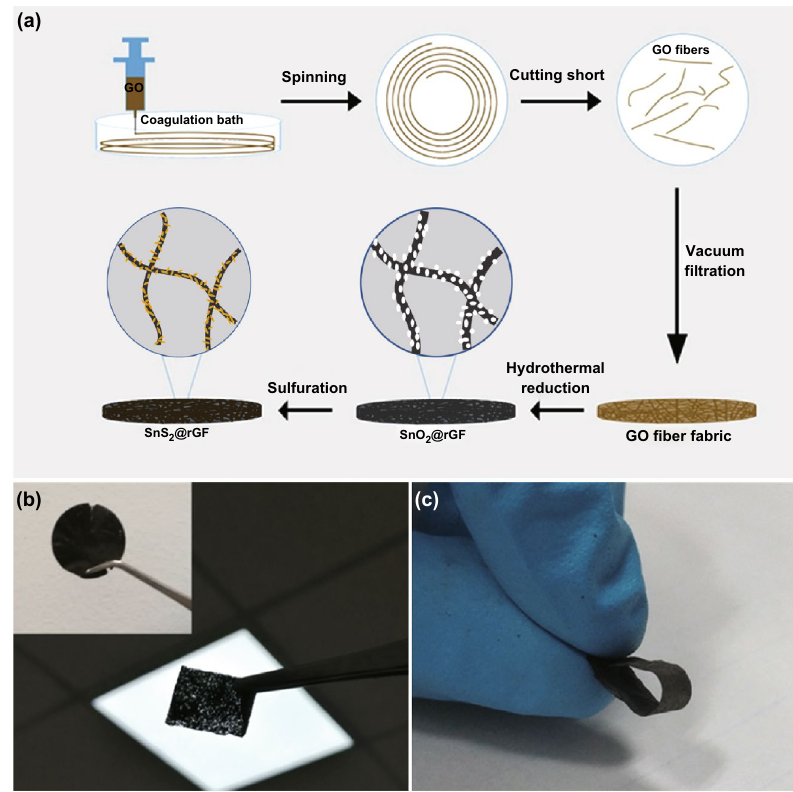
Fig. 1 a Schematic illustration of the preparation process of the SnS 2 @rGF fabrics. b, c Photo images of the SnS 2 @rGF